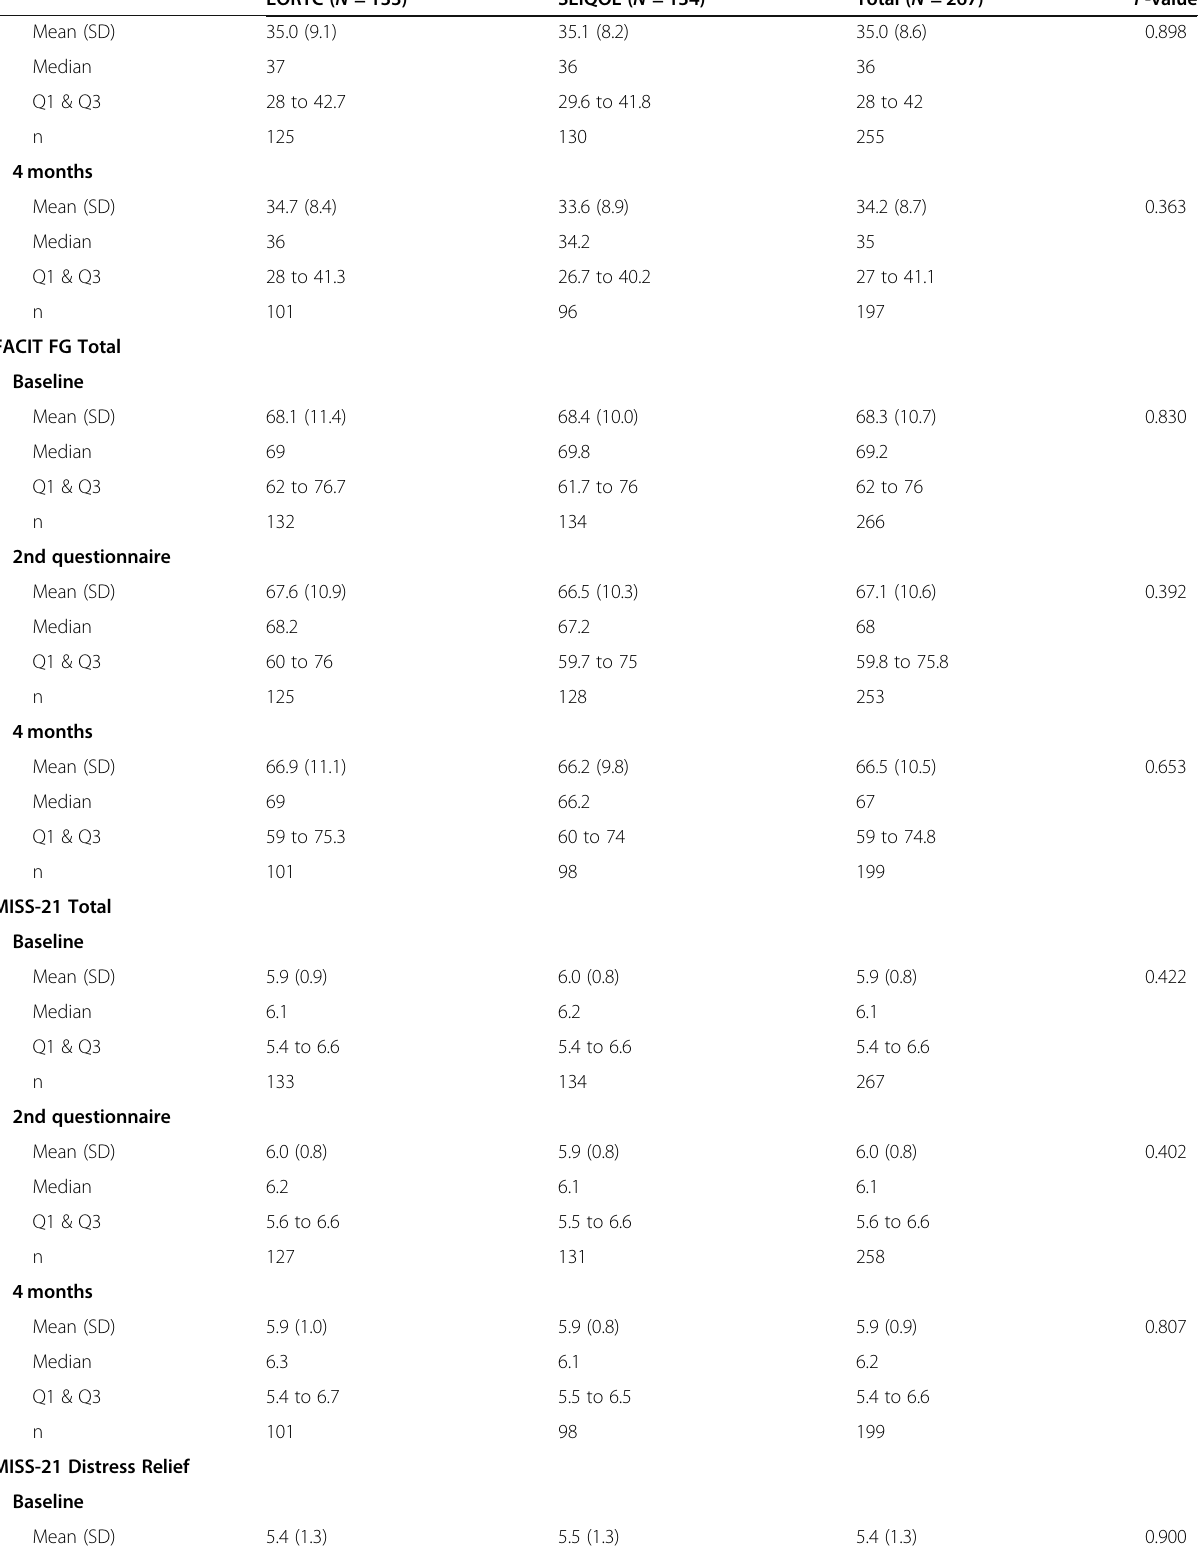
Table 2 Outcomes a over time for analyzed patients